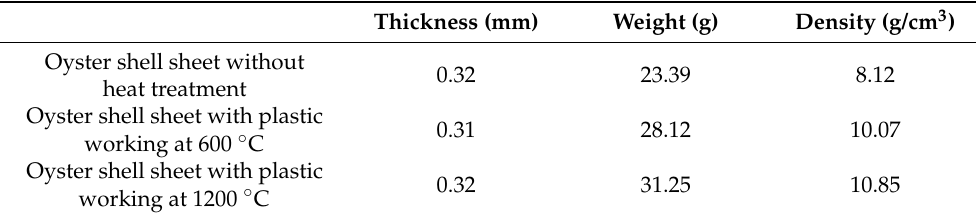
Table 1. Physical properties of the fabricated oyster shell-based shielding